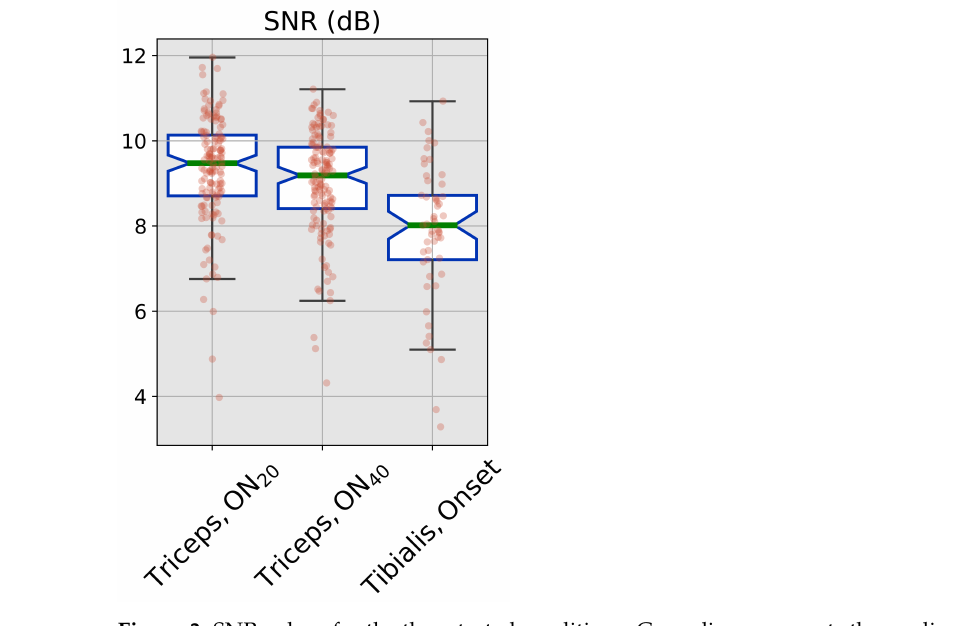
Figure 3. SNR values for the three tested conditions. Green line represents the median, blue lines are the inter-quartile range. Red dots refer to the single